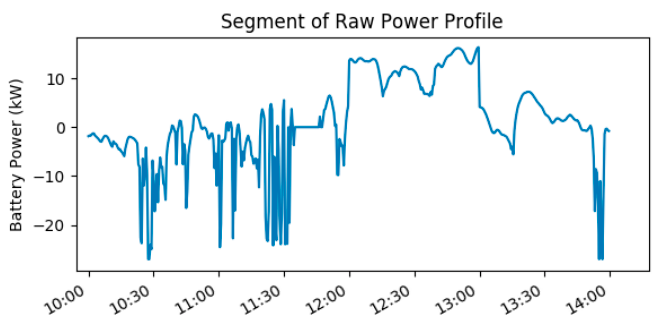
Figure 10. Power profile based on solar correction.